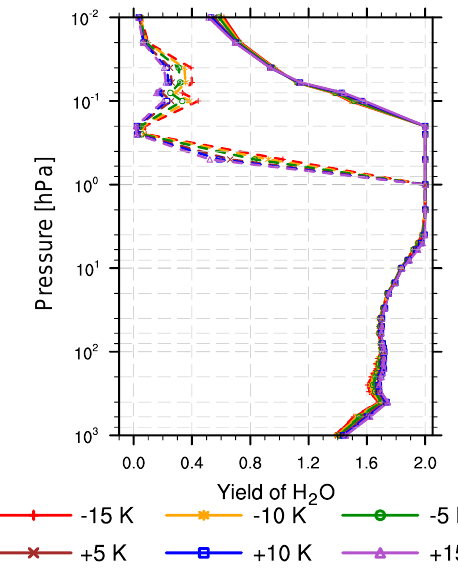
Figure 9. The pseudo-vertical profile of the H 2 O yield calculated by the box model approach. Solid lines represent the direct yield, the dashed lines the effective yield and circles indicate the pres- sure levels of the model boxes. OH is kept constant to the initial values of the respective vertical box. The plot shows sensitivities concerning temperature. Temperature is varied from the standard atmosphere value by − 15K (red), − 10K (orange), − 5K (green), + 5K (brown), + 10K (blue) and + 15K (purple).